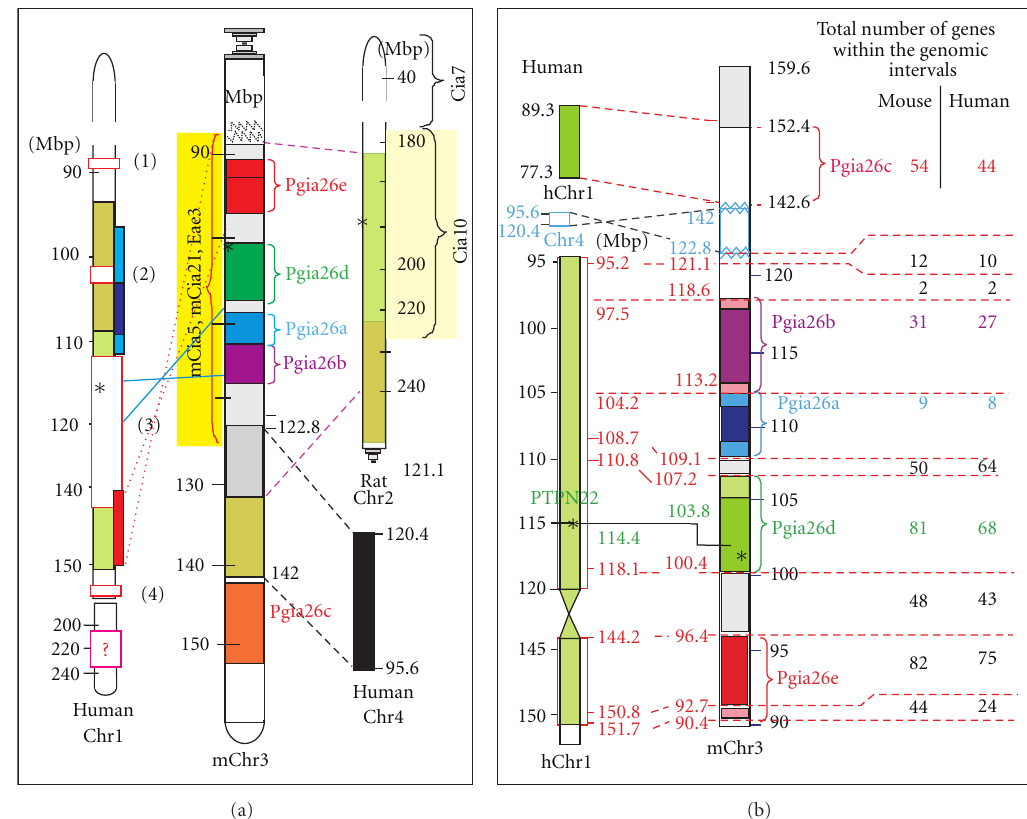
Figure 2: Mouse chromosome 3 (Chr3) with Pgia26 subloci identified in IVSC mice (Figure 1) and corresponding human and rat chromosome regions with their corresponding risk alleles. Panel (a) summarises the location of five Pgia26 subloci with corresponding mouse mCia5 and mCia21 (collagen-induced arthritis) [3, 108, 121], mouse Eae3 (experimental allergic encephalomyelitis) [122, 123] (between mChr1:84.3–126 Mbp), and the corresponding rat Chr2 region of rat Cia10 [124, 125]. The left side of the panel identifies risk alleles on human Chr1 [126], with red-framed boxes and numbers in parentheses indicate the following regions: (1) between 87–89 Mbp [127], (2) 105.4 Mbp [128], (3) 113–142 (including the PTPN22 gene at 114.4) Mbp positions [129–131], and (4) the FCGR family between 158 and 159 Mbp [132, 133]. Panel (b) displays the syntenic risk alleles of human Chr1 and mouse Chr3 ( Pgia26a-e ) with the number of genes localized in the di ff erent chromosome